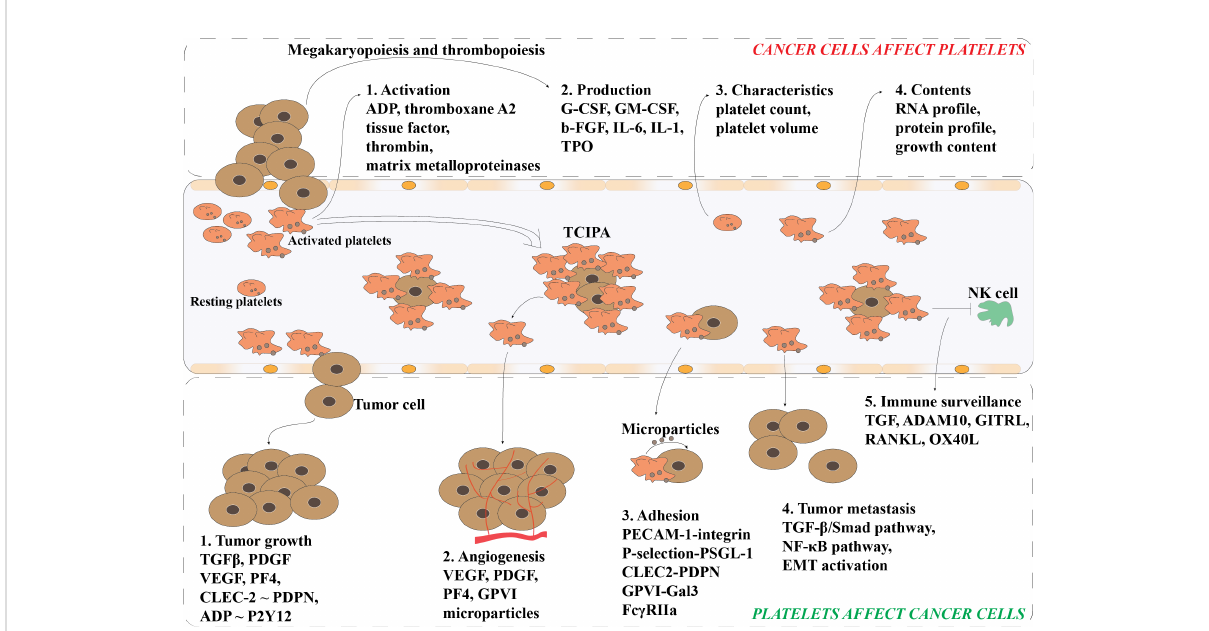
FIGURE 2 Bidirectional interactions of platelets and tumor cells. Cancer cells promote the platelet production and activation via the megakaryopoiesis and thrombopoiesis. Also, the morphological characteristics of platelets (e.g., count and volume) and contents within the platelets (e.g., RNA and protein) can be altered by cancer cells. Activated platelets can release various of mediators to facilitate the tumor growth and cancer metastasis. Activated platelets attach to the circulating cancer cells (CTCs) and enhance their survival in circulation via preventing CTCs from shear fl ow, immune surveillance, and apoptosis. Further, activated platelets also facilitate the adhesion and angiogenesis of CTCs. TCIPA, Tumor Cell- Induced Platelet Aggregation; G-CSF, Granulocyte- Colony-Stimulating Factor; GM-CSF, Granulocyte-Macrophage-Colony-Stimulating Factor; b-FGF, Basic Fibroblast Growth Factor; IL-1, Interleukin-1; IL-6, Interleukin-6; TPO, thrombopoietin; TGF b , Transforming Growth Factor b ; PDGF, Platelet-Derived Growth Factor; VEGF, Vascular Endothelial Growth Factor; PF4, Platelet Factor 4; PDPN, Podoplanin; CLEC2, C-type lectin receptor type 2; ADP, Adenosine 5 ’ Diphosphate; P2Y12, platelet P2Y12 receptor (P2Y12R) for ADP; GPVI, Platelet Glycoprotein VI; PECAM- 1, Platelet-Endothelial Cell Adhesion Molecule-1; PSGL-1, P-selectin Glycoprotein Ligand-1; Gal3, Galectin-3; Fc g RIIa, The Platelet Fc Gamma Receptor II Type